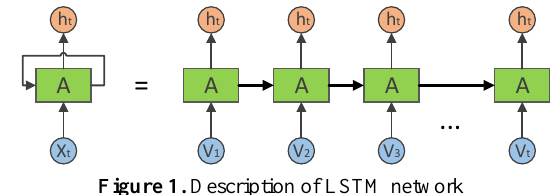
Figure 1. Description of LSTM